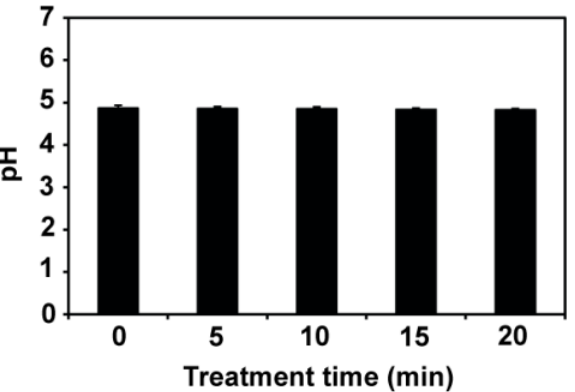
Figure 6. The pH measurement in the PDB media post plasma treatment of the fungal spores for 5, 10, 15, and 20 min. Untreated (0 min) fungal spores were used as a control. The pH was measured immediately after plasma treatment. Each value is indicated as the mean and standard deviation of 9 replicate